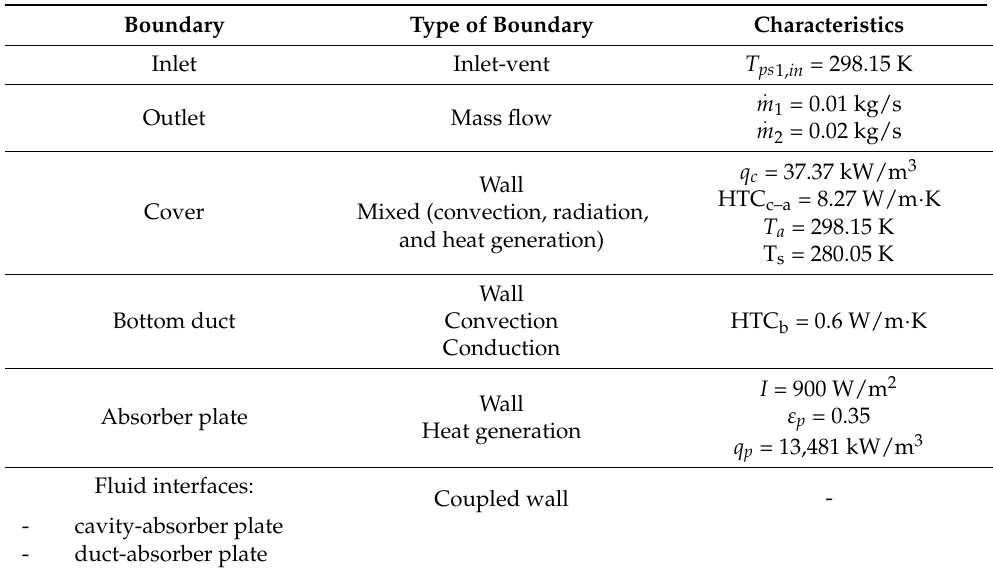
Table 4. Boundary conditions considered in the CFD modeling of the U-shape double-pass CPC. Boundary Type of Boundary